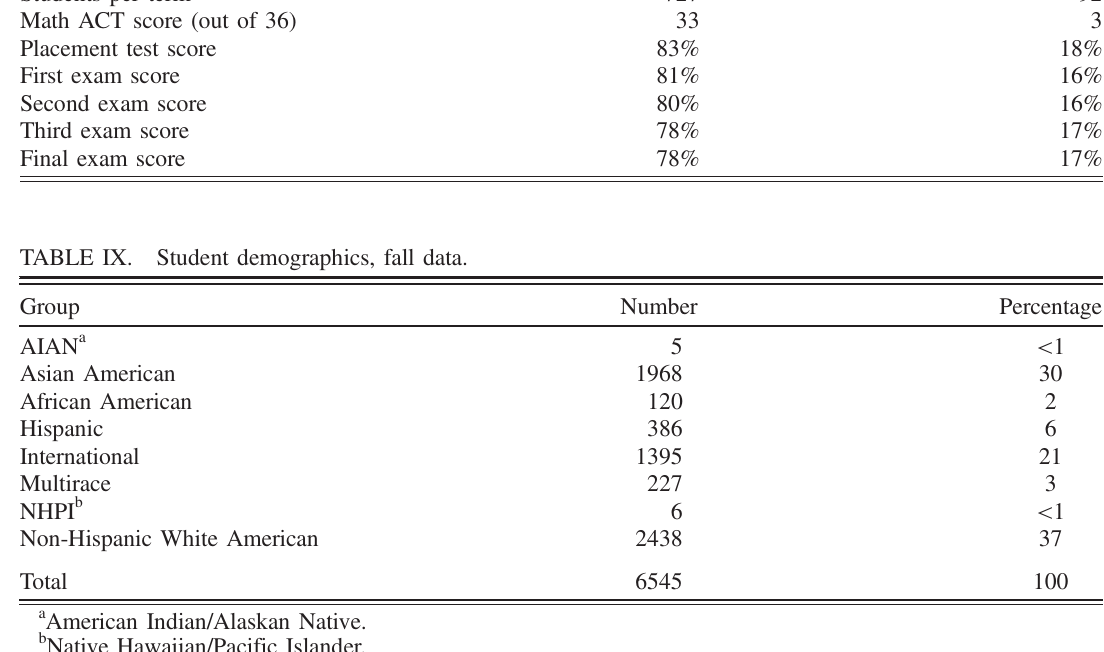
TABLE VIII. Means and standard deviations of enrollment numbers and test scores, fall data. Characteristic Mean Students per term